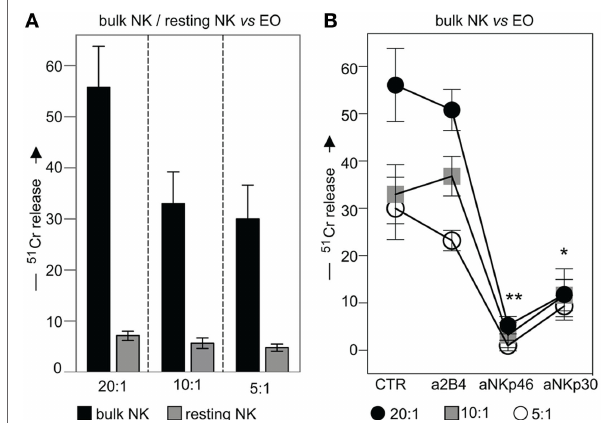
FigUre 7 | cytolytic activity of il2-conditioned or resting nK cells against eosinophils (eOs) freshly purified from healthy non-atopic donors . (a) IL2-conditioned (bulk) or resting NK cells were tested in 51 Cr-release assay against EOs at various E : T ratios. Black bars represent lysis by bulk NK cells; gray bars refer to lysis by resting NK cells. The average of six independent experiments is shown (% ± SD). (B) IL2-conditioned NK cells (bulk) were analyzed for their cytolytic activity against EOs in the absence or in the presence of the indicated blocking mAbs at various E : T ratios. Black circles: E : T ratio of 20:1; gray squares: E : T ratio of 10:1; white circles: E : T ratio of 5:1. The average of six independent experiments is shown (% ± SD). * P < 0.05; ** P <